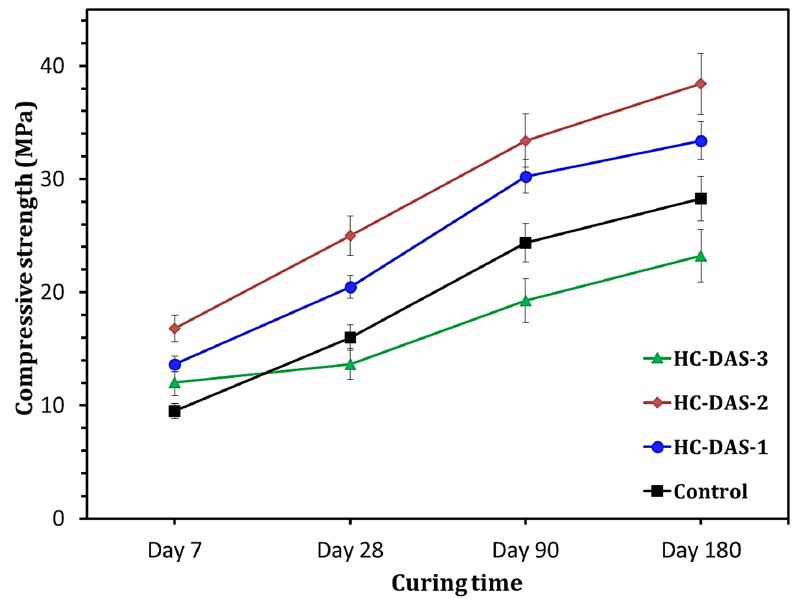
Figure 8. Compressive strength of the hardened BFS-OPC blend and one-part HC mortars. Cement hydration and alkali BFS activation are the two synergistic mechanisms of one-part HC mortar. The activated aluminosilicate-species-containing DAS interacts with water to yield C-A-S-H and NaOH (Figure 5). The unreacted BFS within DAS is dissolved by the liberated NaOH through the alkali-activation process, yielding C-N-A-S-H, as con- firmed by XRD analysis (Figure 8). On the other hand, the OPC within one-part HC mortar also interacts with water to produce C-S-H and Ca(OH) 2 . An additional C-N-A-S-H could be formed through the consumption of Ca(OH) 2 by the activated species resulted from alkali BFS-activation. In contrast, the formation of strength-giving phases is resulted from the pozzolanic reaction, as C-S-H and/or C-A-S-H are formed through the interaction be- tween aluminosilicate within BFS and Ca(OH) 2 resulted from OPC hydration. It is recognized that the enhancement of hydration products’ content strongly reflects on the mechanical properties of the hydrated cement [37,41,53,61,62]. Accordingly, a rela- tionship between compressive strength and hydration products content (determined by TG analysis) within cement pastes hydrated for 28 days is represented in Figure 9. Increas- ing NaOH content (up to 2 wt.%) enhances formation of the hydration products and com- pressive strength. Although the hydrated sample having 3 wt.% exhibits the highest hy- dration products content, it demonstrated compressive strength values lower than those of other HC mixtures and the control sample. These variations in outcomes confirm the fact that the DAS with appropriate Na 2 O content should be prepared to achieve the high performance of one-part HC.